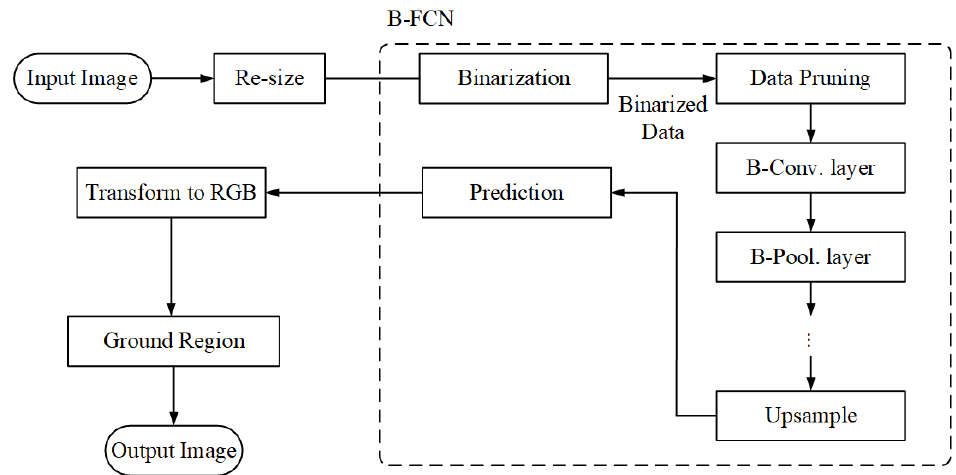
Figure 5. Flow Architecture of B-FCN to ZCU104 SoC